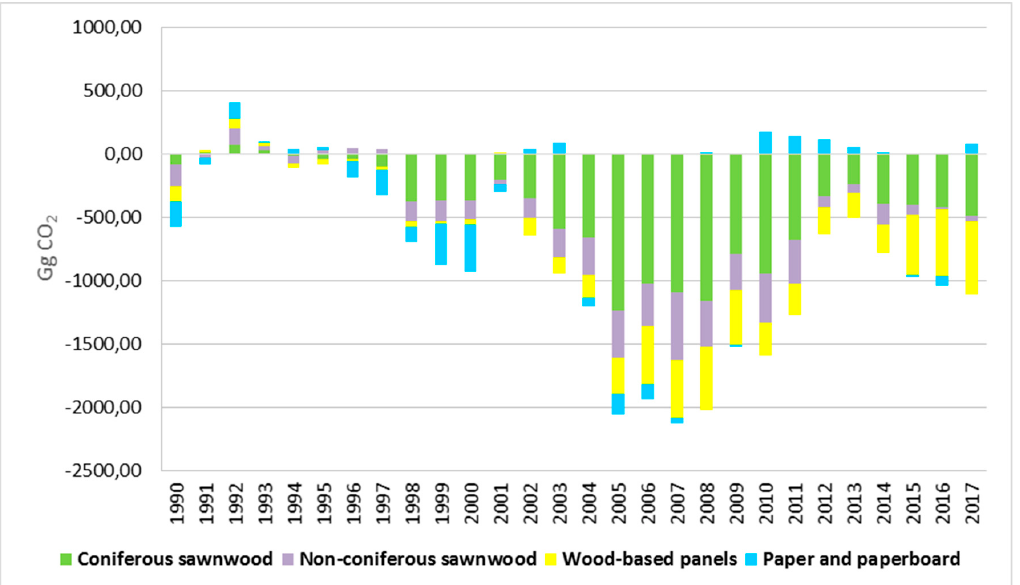
Figure 1. The balance of CO2 from domestically used harvested wood products (S0 scenario) . Note: Positive values indicate CO2 emissions released into the atmosphere from consumed wood products. Negative values indicate amount of CO2 stored in harvested wood products.